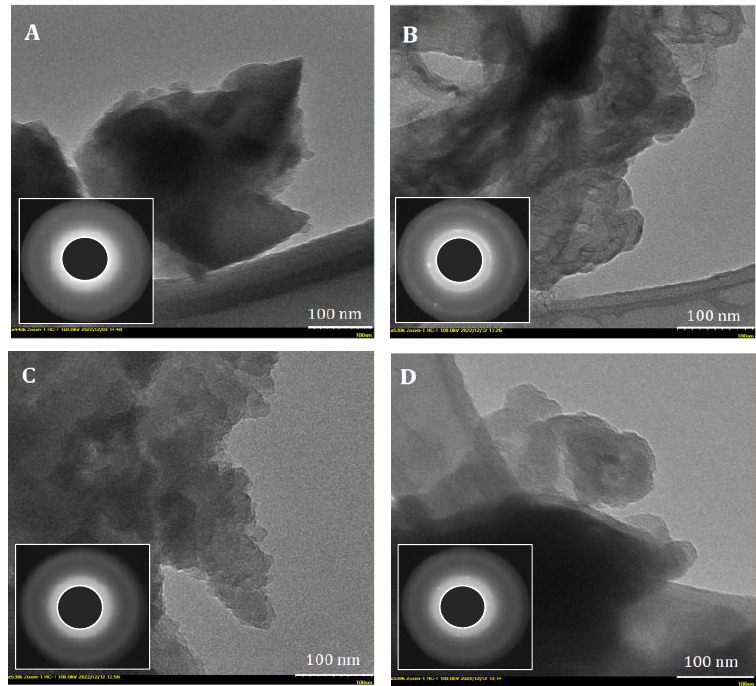
Figure 10. Representative TEM (bar scale 100 nm) images (inset: SAED patterns) of the ACMP type analyzed: ( A ) walnut shells; ( B ) peach kernels; ( C ) apricot kernels; ( D ) olive kernels.